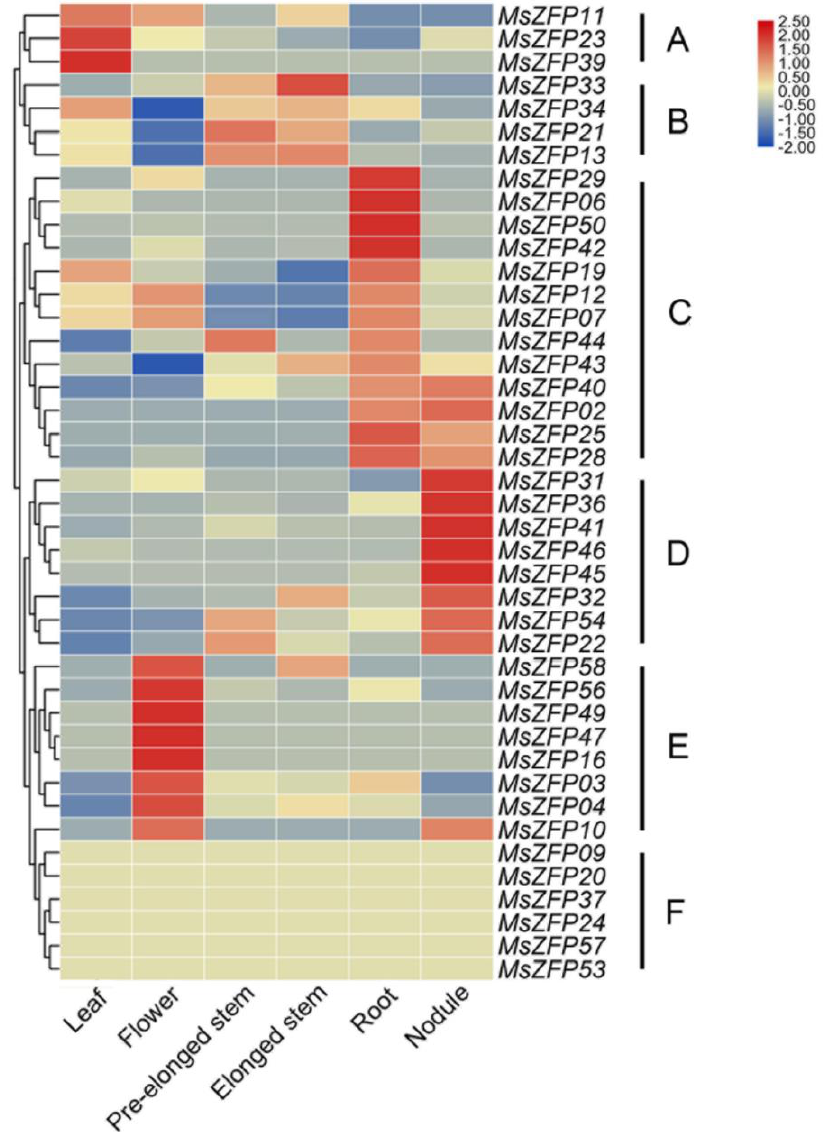
Figure 6. Heatmap representation of the expression patterns of MsZFP s among different tissues. Lower and higher levels of transcript accumulation are indicated by red and blue, respectively, and the median level is indicated by light yellow. Microarray data were downloaded from the CADL-Gene Expression Atlas database, and the heatmap was constructed using TBtools. Subgroups A to F displayed the highest transcript accumulation level in different tissues.